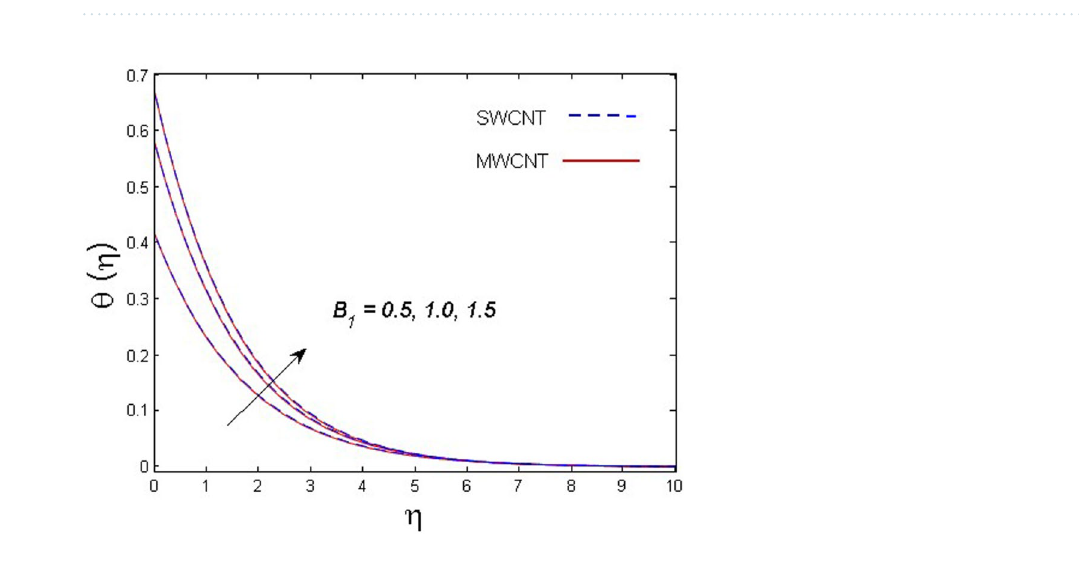
Figure 8. Outcome of B 1 on θ η ( )